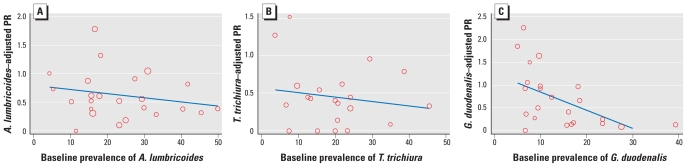
PR of infection with (A) A. lumbricoides, (B) T. trichiura, and (C) G. duodenalis (after vs. before the intervention) plotted against baseline prevalence of the respective parasite in each sentinel area; 1,657 children 0–4 years of age, in Salvador, Brazil, 1997–1998 and 2003–2004. PRs are adjusted for age and sex. Each point represents the estimate for a sentinel area, and its size reflects the number of households in that area. The line on each graph is fitted by bivariate linear regression, weighted by the number of households in each sentinel area.